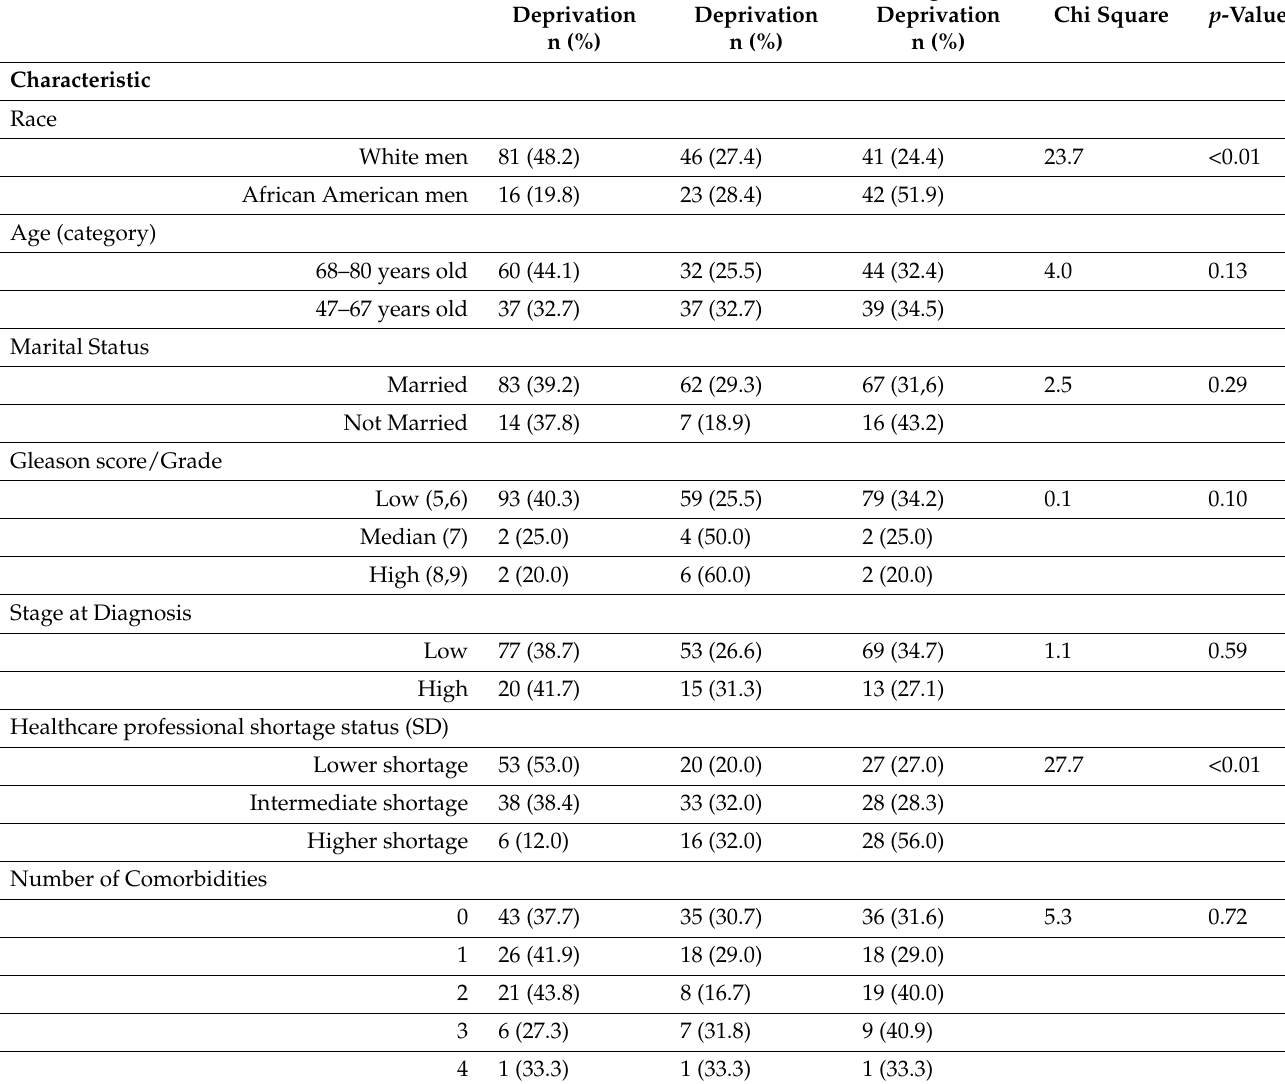
Lower Intermediate Higher Deprivation Deprivation Deprivation Chi Square p n (%) n (%) n (%)